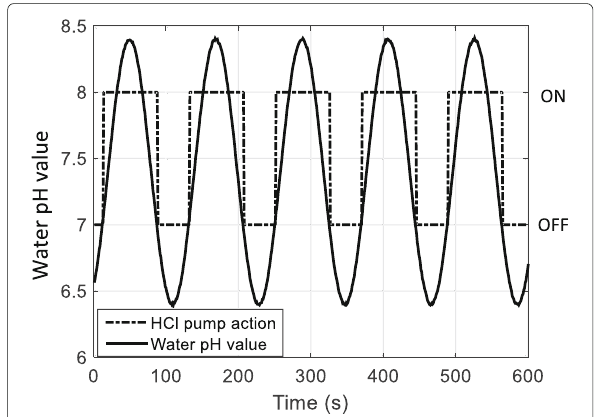
Fig. 6 The relationship between the water’s pH value and the actions of the HCl pump